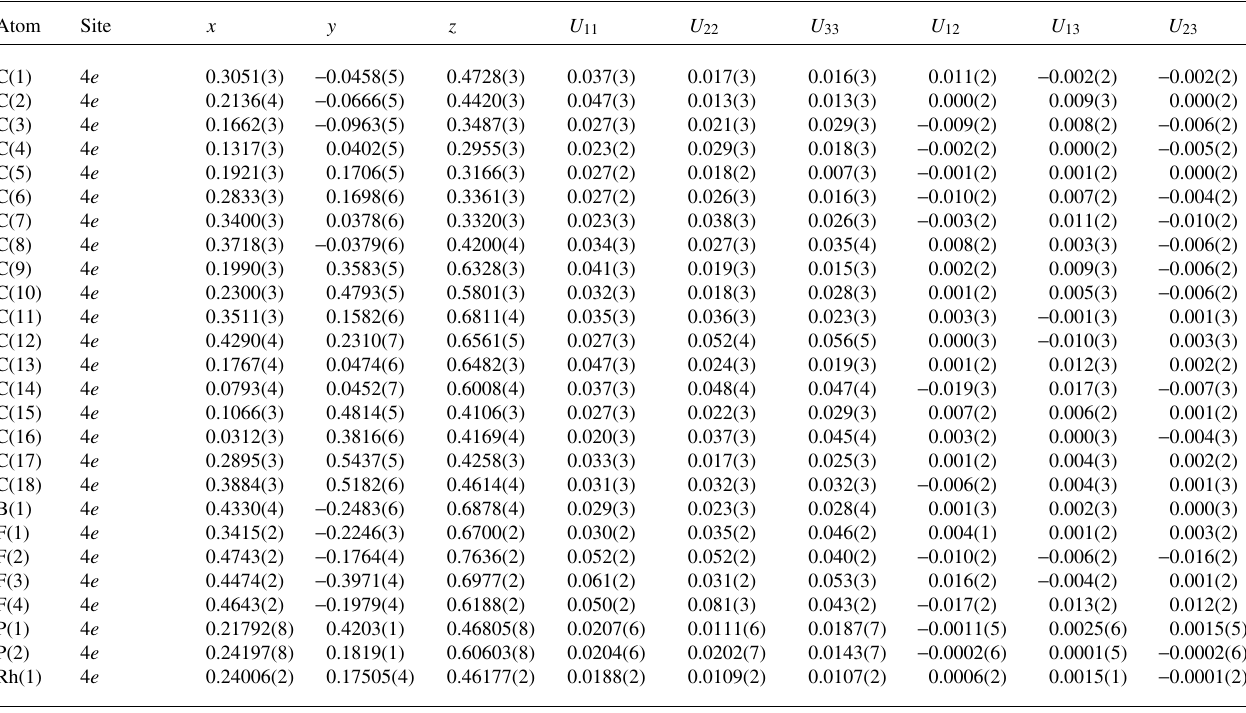
Table 3. Atomic coordinates and displacement parameters (in Å 2 )